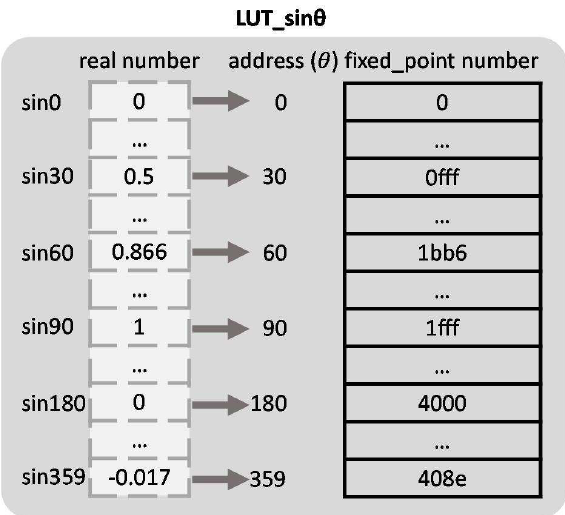
Figure 1. Example of the look-up-table (LUT) for sin θ